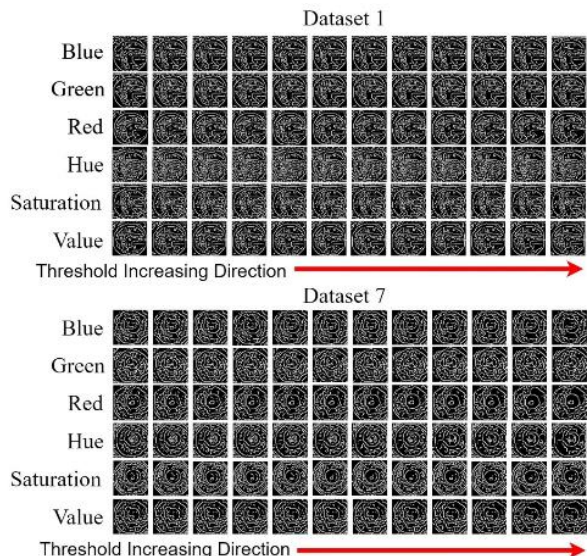
Figure 52. Results obtained after Canny edge detection.